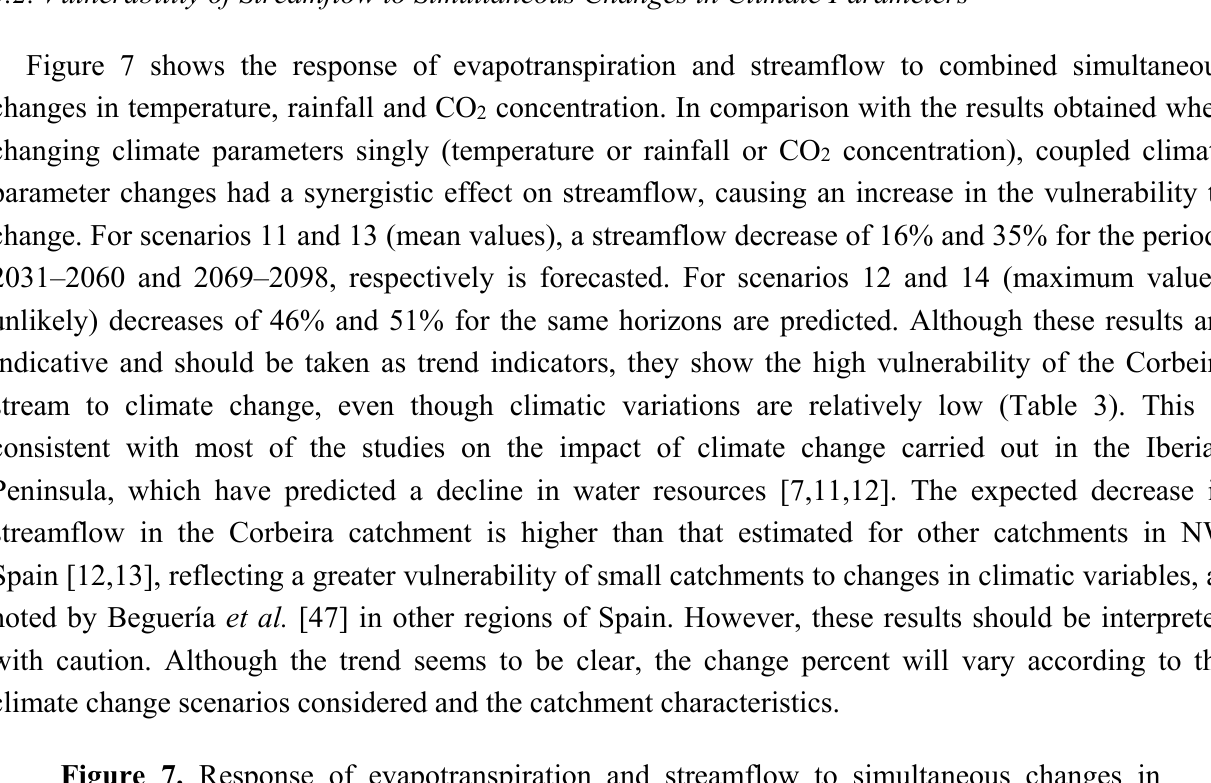
Figure 7. Response of evapotranspiration and streamflow to simultaneous changes in temperature, rainfall and CO 2 concentration based on the scenarios defined in Table